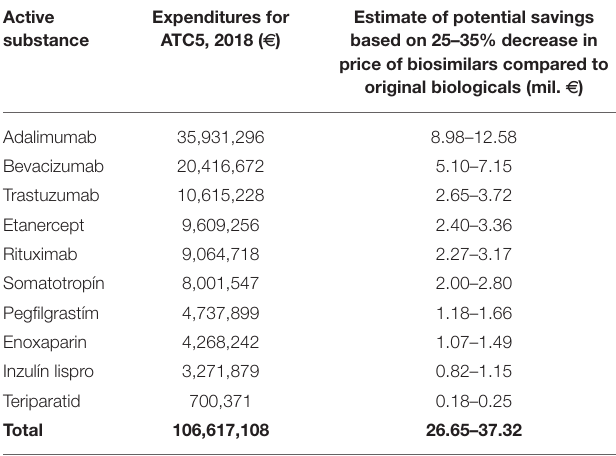
TABLE 3 | Estimate of financial savings from biosimilars, based on data from the National Health Information Center. Active Expenditures for substance ATC5, 2018 ( e